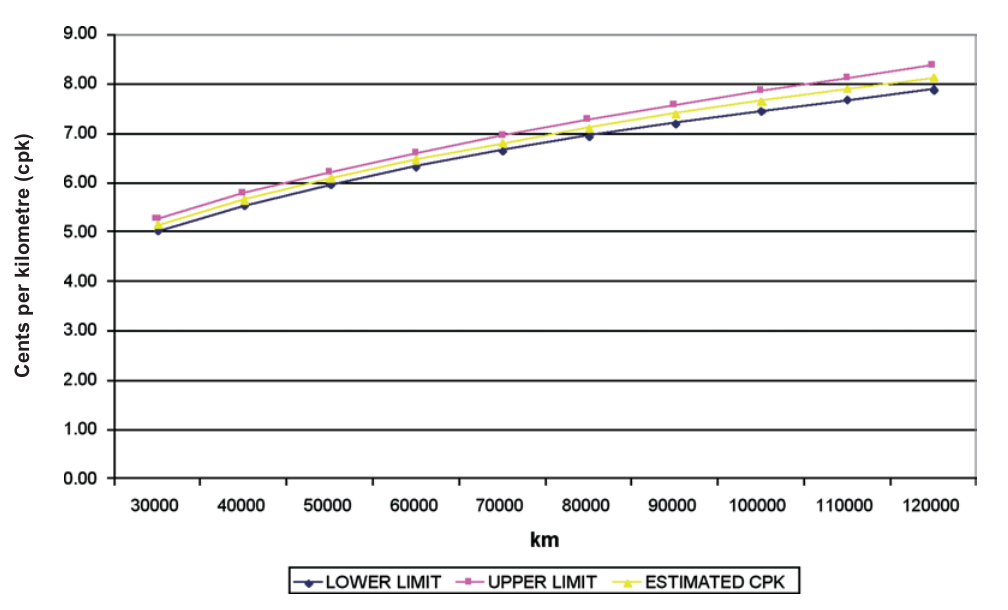
Figure 3: Estimated average maintenance costs and confidence